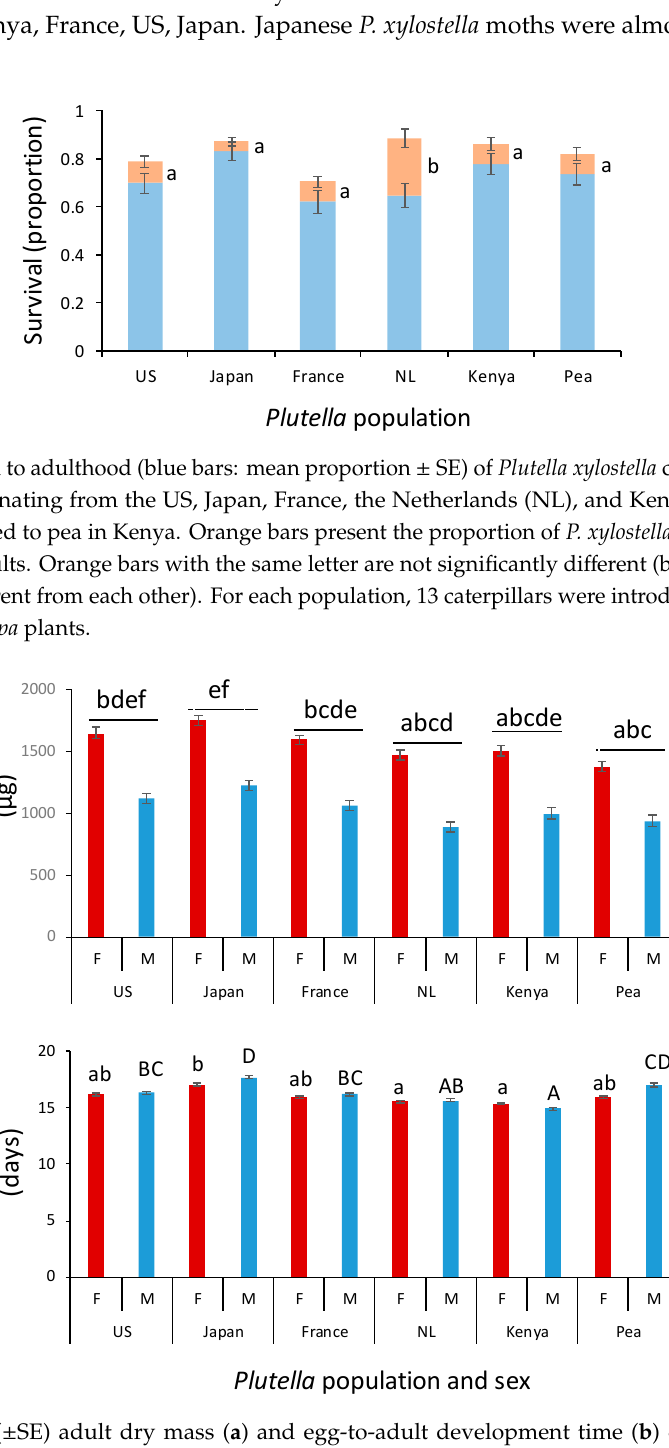
Figure 2. Mean ( ± SE) adult dry mass ( a ) and egg-to-adult development time ( b ) of females (red bars) and males (blue bars) of Plutella xylostella populations originating from the US, Japan, France, the Netherlands (NL), and Kenya, as well as a population adapted to pea in Kenya. Thirteen caterpillars of each population were introduced on each of 10 to 12 Brassica rapa plants. Male (capital letters) and female (small letters) data were analyzed separately in panel ( b ). Bars with the same letter are not significantly different.